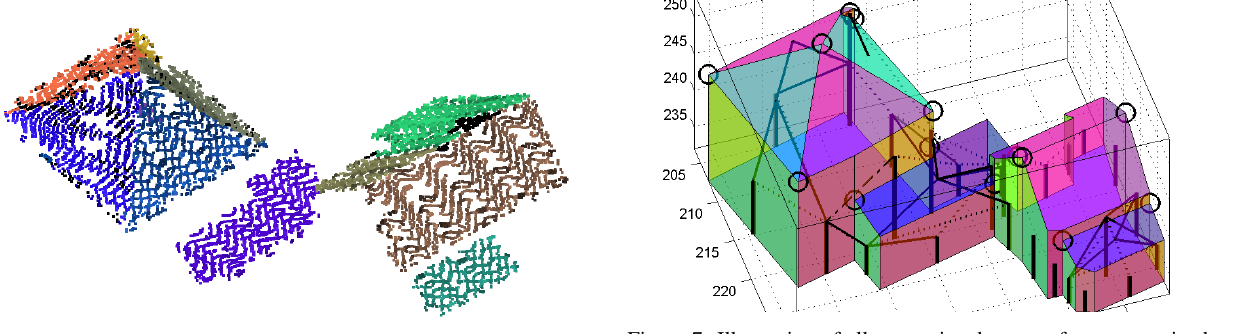
Figure 6: RANSAC-based shape detection.